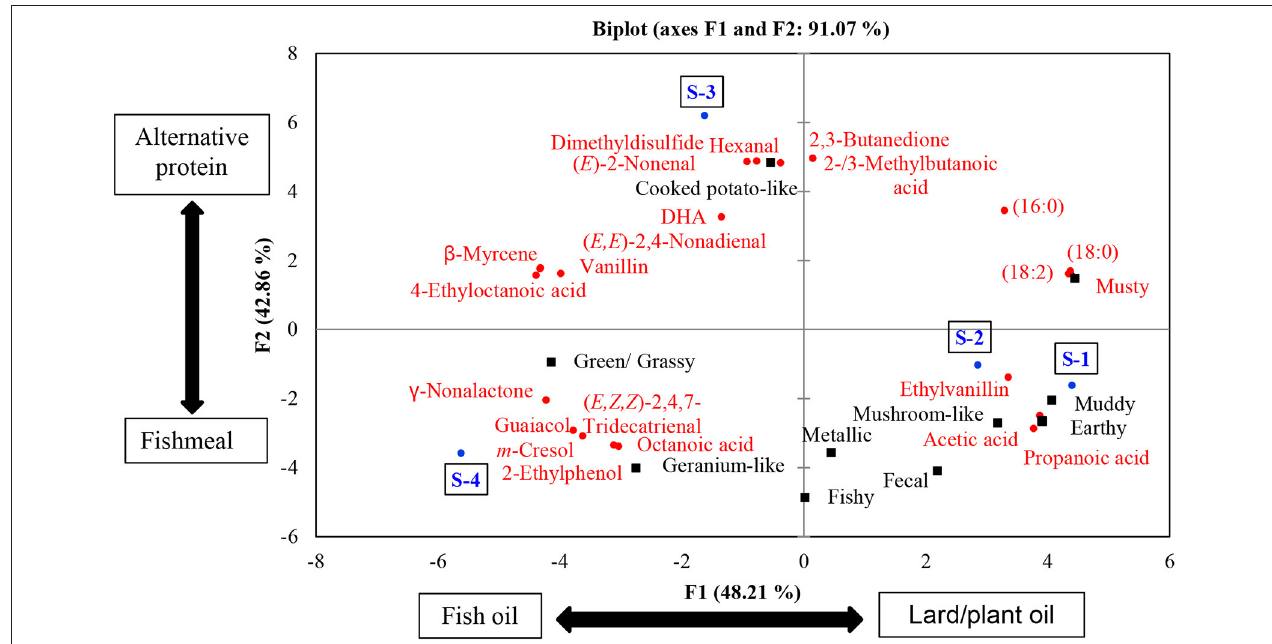
FIGURE 5 | PCA bi-plot of odorants and fatty acid analyses showing two principal components that explain 91.07% of the variation. The blue color represents samples, the black color represents sensory attributes, and the red color represents chemical variables.